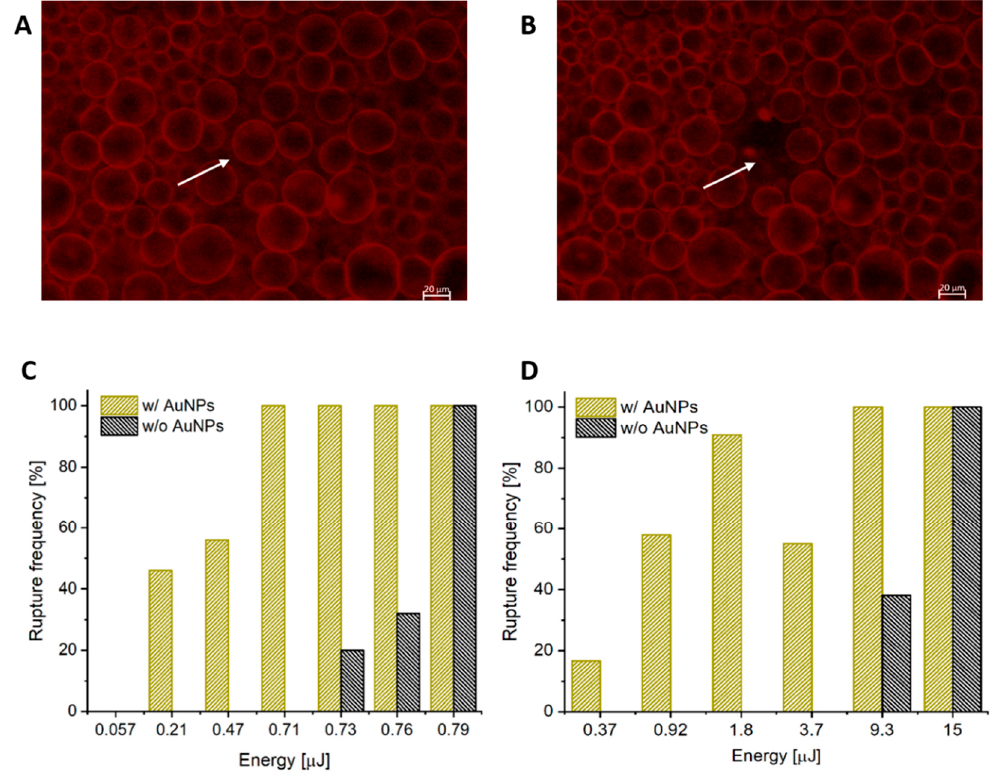
Figure 3. ( A ) Polymersomes with Nile red and 0.066% ( w / v ) AuNPs encapsulated in the hydrophobic region of the membrane, prior to laser irradiation. ( B ) The polymersome indicated by the white arrow was irradiated with a single 532 nm fs pulse and immediately imaged. Complete rupture of the polymersome is observed while the surrounding vesicles remain intact. Scale bar represents 20 µm. ( C ) Rupture statistics for polymersomes upon femtosecond irradiation. Rupture frequency of polymersomes with AuNPs within the membrane (gold) and without AuNPs (black) are shown. These percentages represent the number of vesicles undergoing complete rupture upon irradiation by a single 532 nm fs pulse at the specified energies. A minimum of 20 vesicles were irradiated per pulse energy. ( D ) Rupture statistics for polymersomes using nanosecond irradiation. The percentage of polymersomes rupturing in response to varying ns pulse energies was determined for populations of vesicles with (gold) and without (black) AuNPs in the membrane. These percentages represent complete rupture upon irradiation by a single 532 nm, ns pulse at the specified energies.